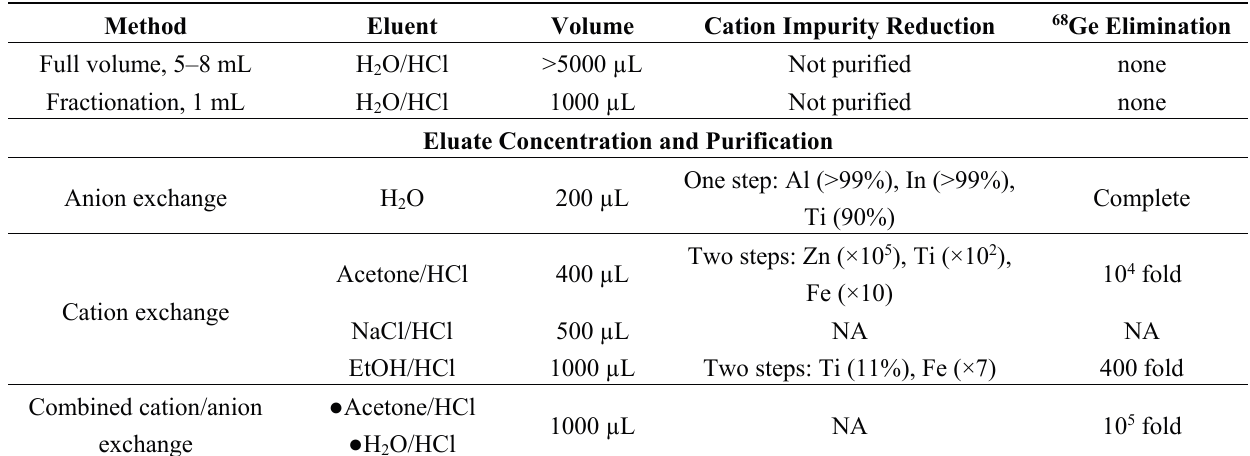
Table 4. Basic methods of 68 Ge/ 68 Ga generator eluate utilization.